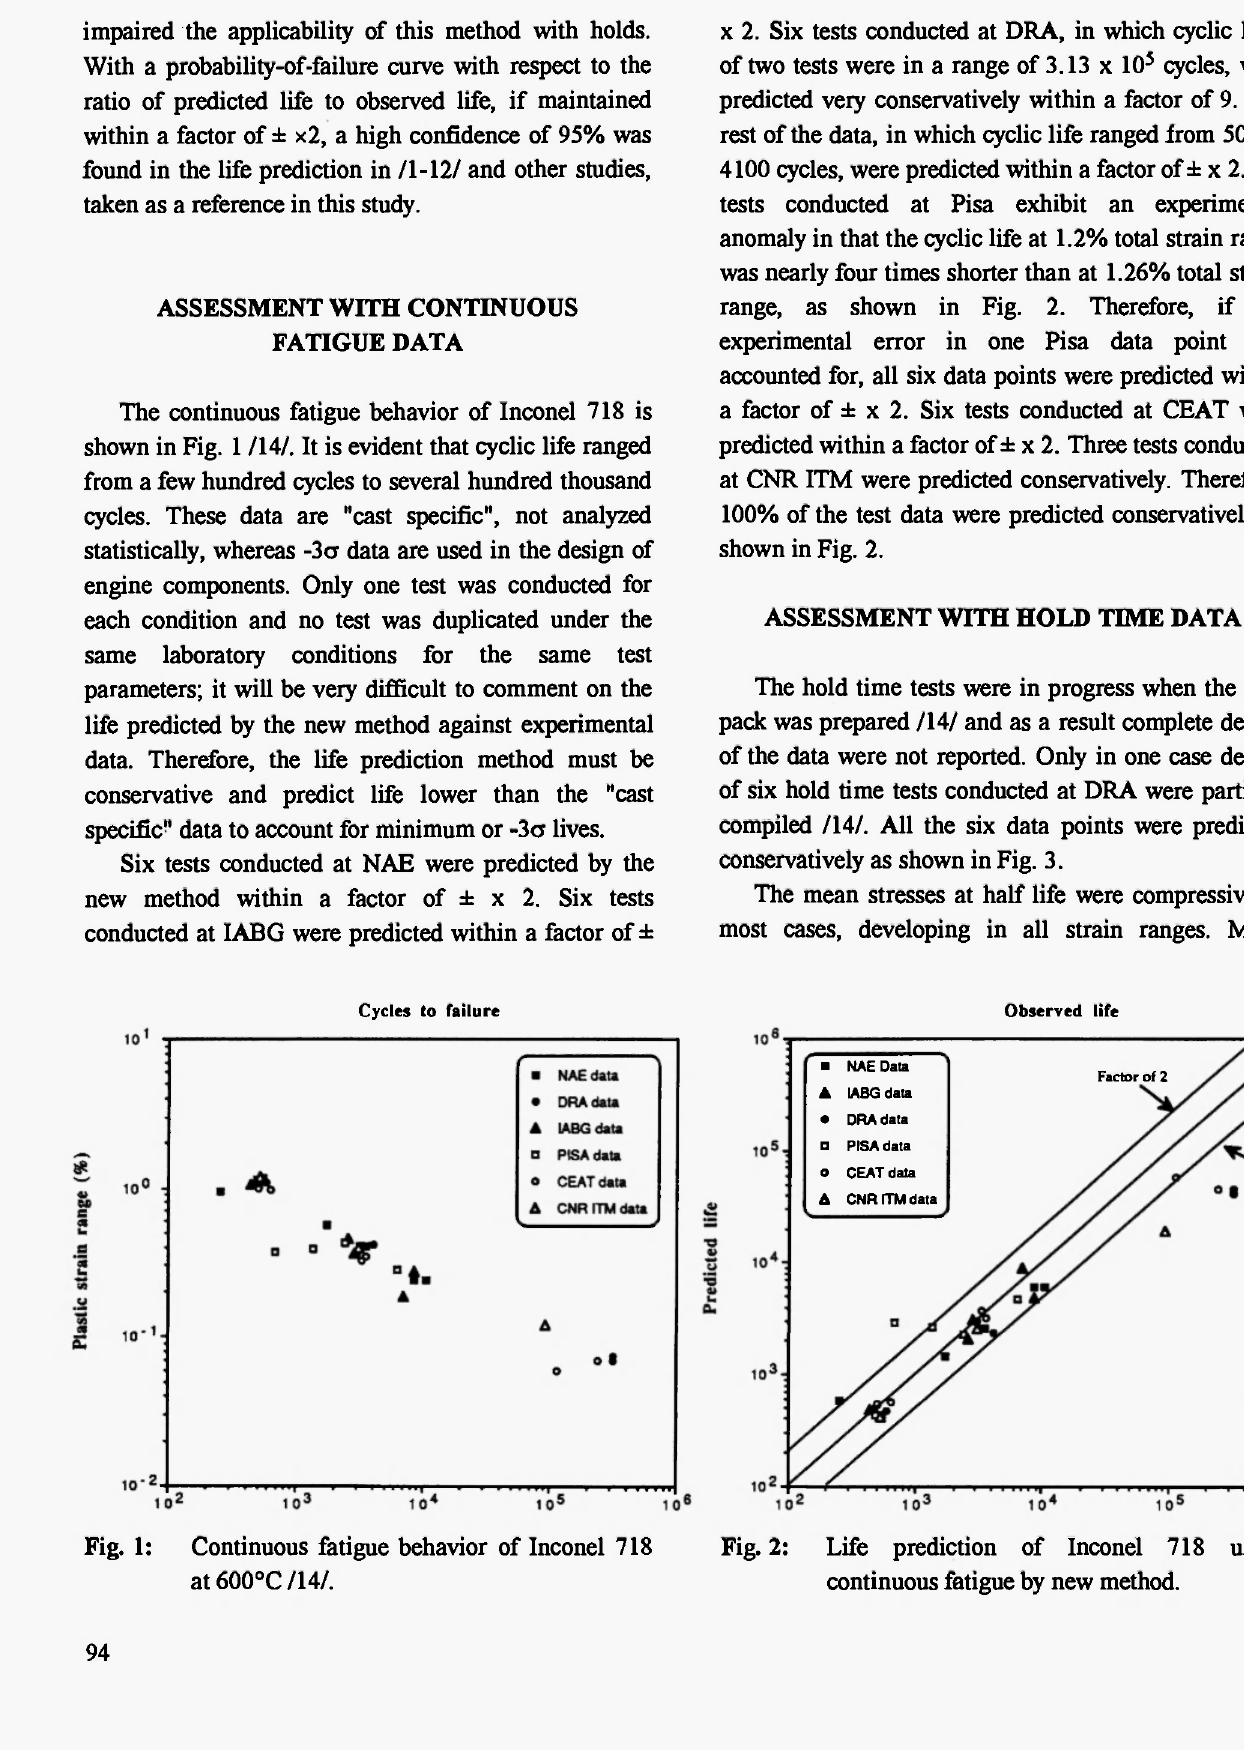
Fig. 1: Continuous fatigue behavior of Inconel 718 at 600°C /14/.